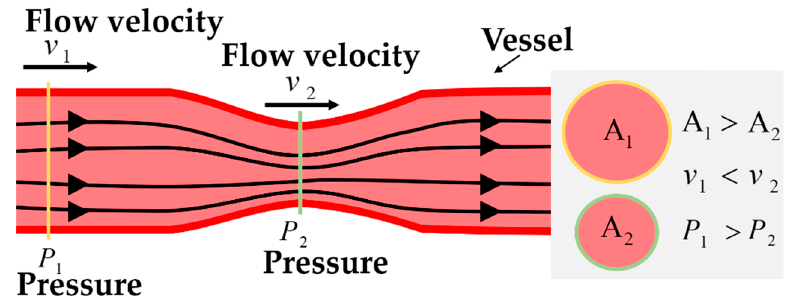
Figure 2. Bernoulli’s law in the vessel.